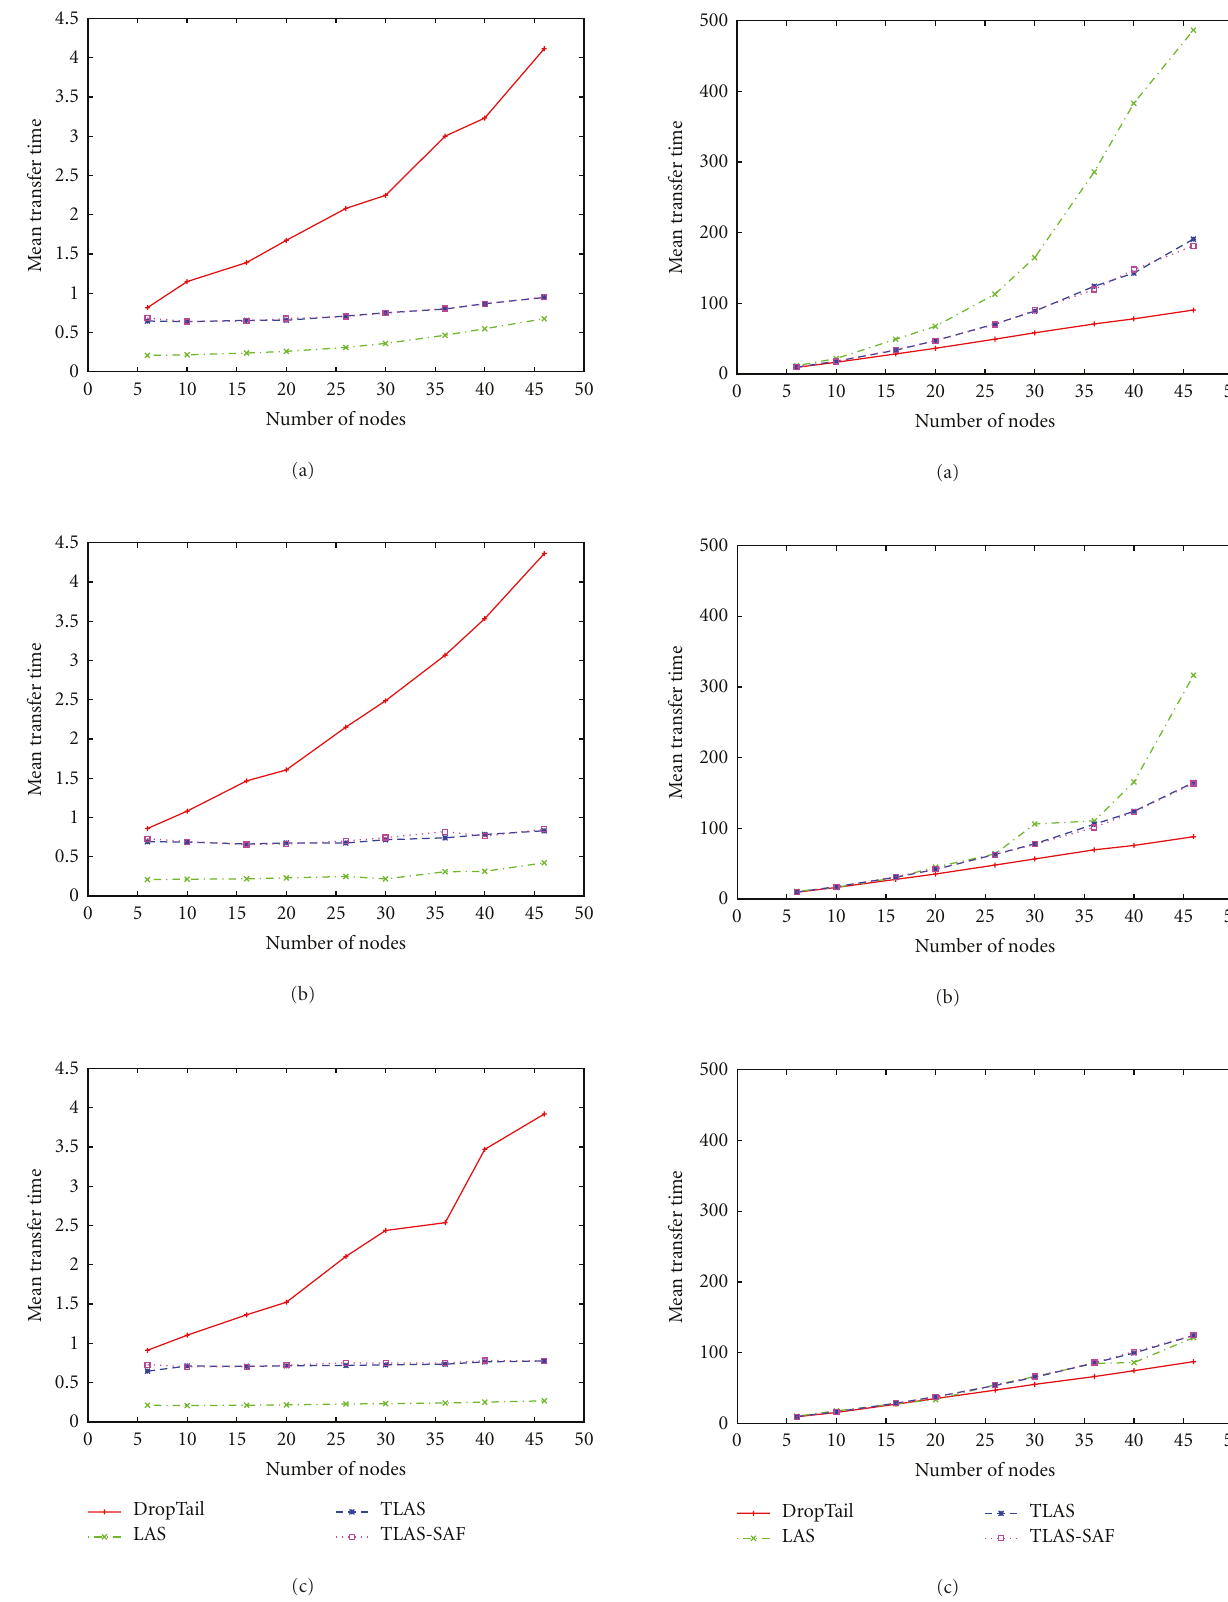
Figure 9: Mean transfer time of large files for short flow interarrival time: (a) 250 ms; (b) 500 ms; (c) 1